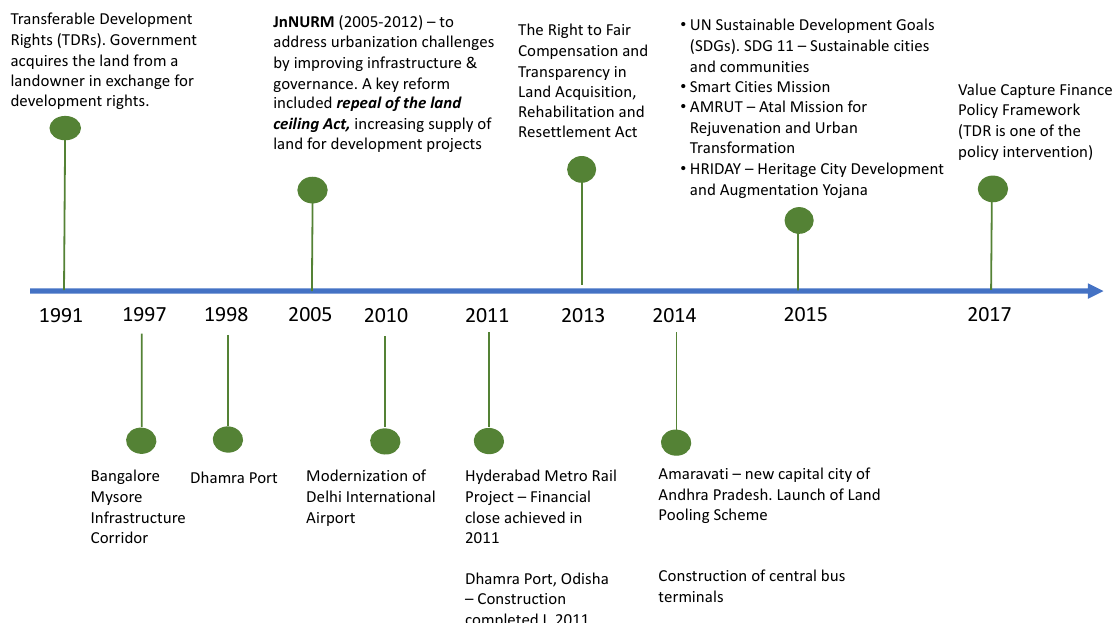
Figure 1. Key projects and legislations/policies.